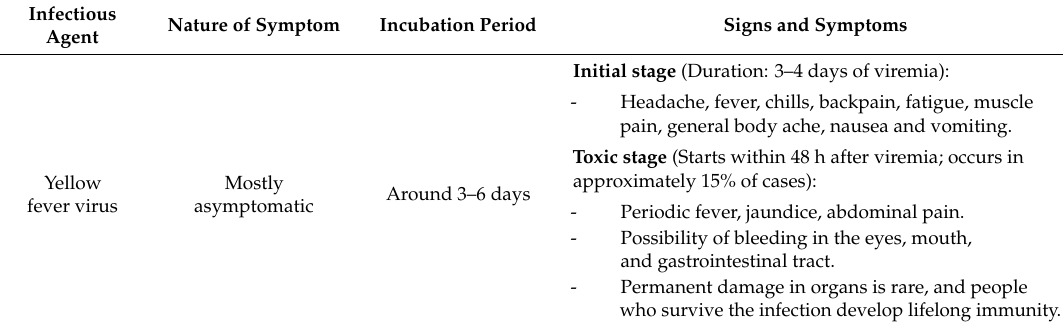
Table 2. Clinical features of some